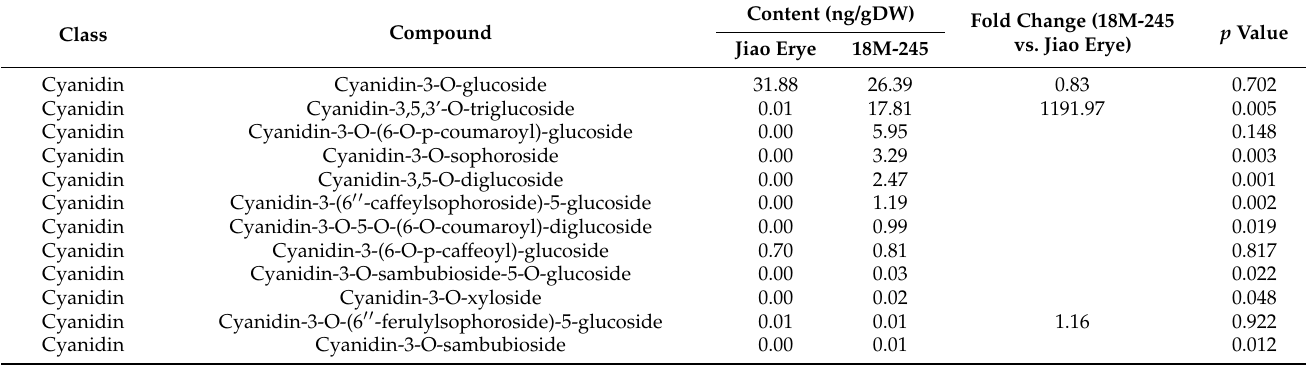
Figure 6. BjuB014115 is regulated by MYB and bHLH transcription factors from the Brassica A genome. Distribution of bHLH-binding site G-boxes and MYB-binding sites in the promoter of BjuB014115 ( A ). Interactions between TFs from the Brassica A genome with promoter fragments of BjuB014115 were examined using yeast-one hybridization ( B ). Positive clones were screened in SD/-Leu medium, then interactions between the TFs with the BjuB014115 promoter fragment were identified in 800 ng/mL ABA. All clones contained the recombinant AD plasmid. Positive clones were then diluted 10-fold with sterile water to further test their resistance to ABA. Table 1. The contents of different anthocyanin compounds in the 18M-245 and Jiao Erye leaves based on